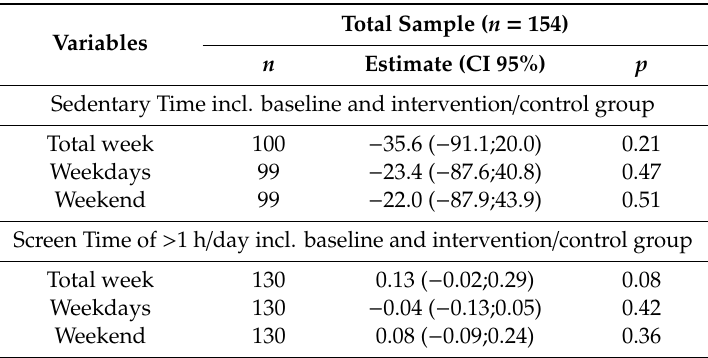
Table 3. Final mixed e ff ects regression model for binary